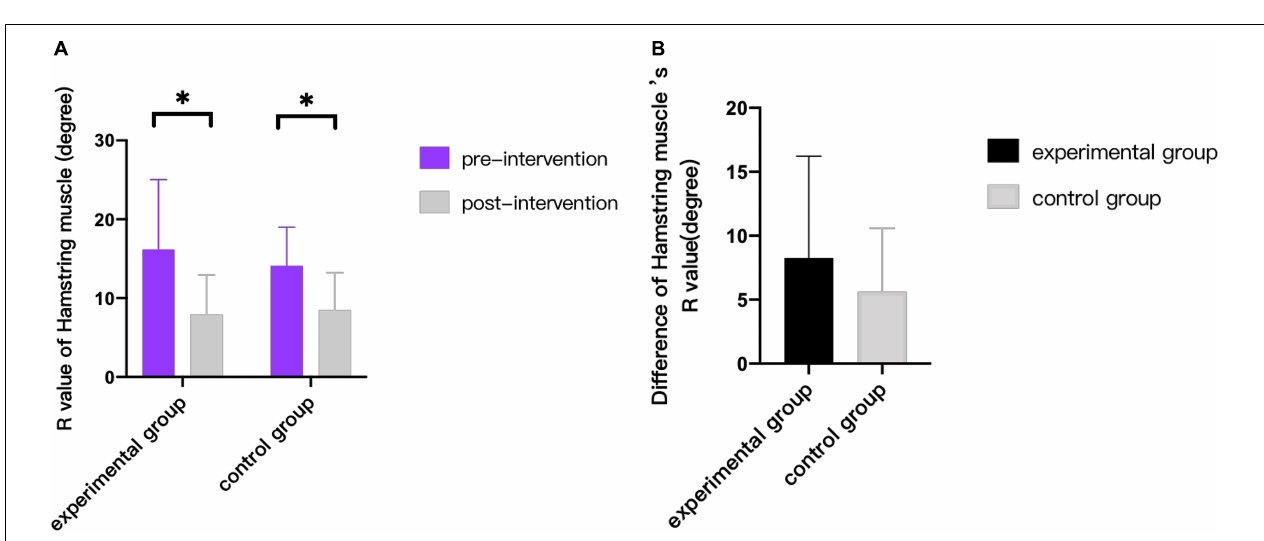
FIGURE 3 | Comparison of GMFM-66 scores. (A) Comparison of score value in the same group before and after treatment. (B) Comparison of differences between the two groups before and after treatment. * indicates intra-group p < 0.05, and # indicates inter-group p < 0.05.